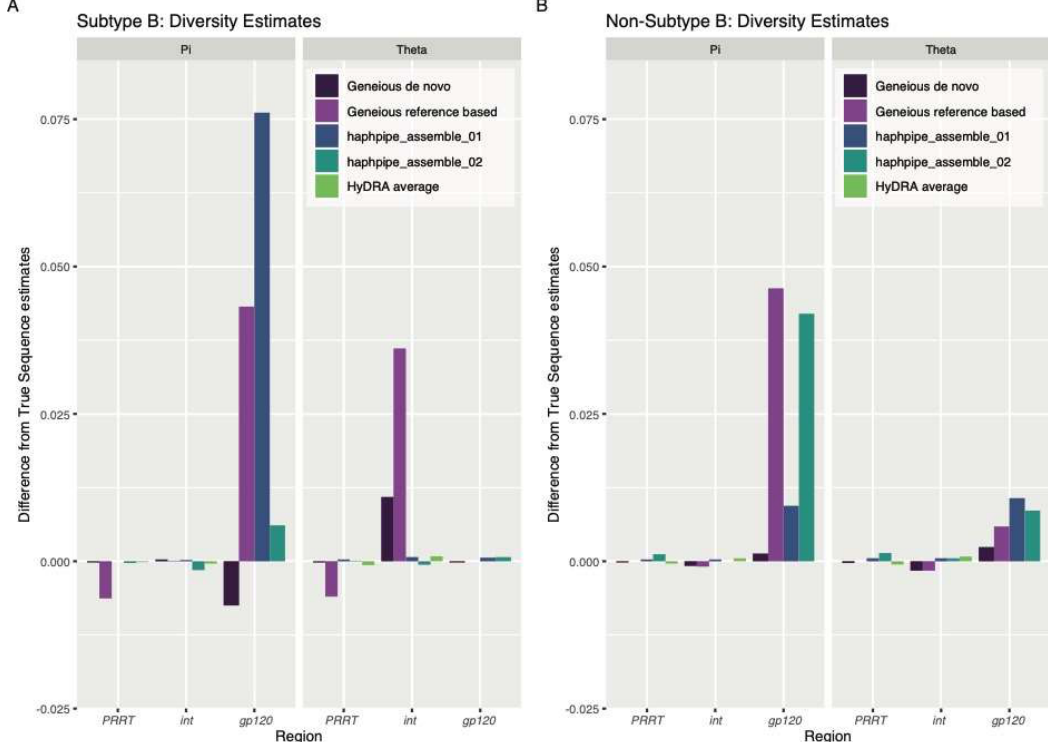
Figure 4. Difference between the estimated genetic diversity from the true sequence and each pipeline (calculated as estimate of true sequences—estimate of pipeline consensus sequences) for the simulated HIV ( A ) subtype B dataset and ( B ) non-subtype B dataset. Positive value indicates an underestimation of the genetic diversity with the consensus sequences from the pipeline, and a negative value indicates an overestimation of the genetic diversity with the consensus sequences from thepipeline. PRRT = protease and reverse transcriptase, int = integrase, gp120 = gene within envelope gene region, Pi = nucleotide diversity, Theta = Watterson’s genetic